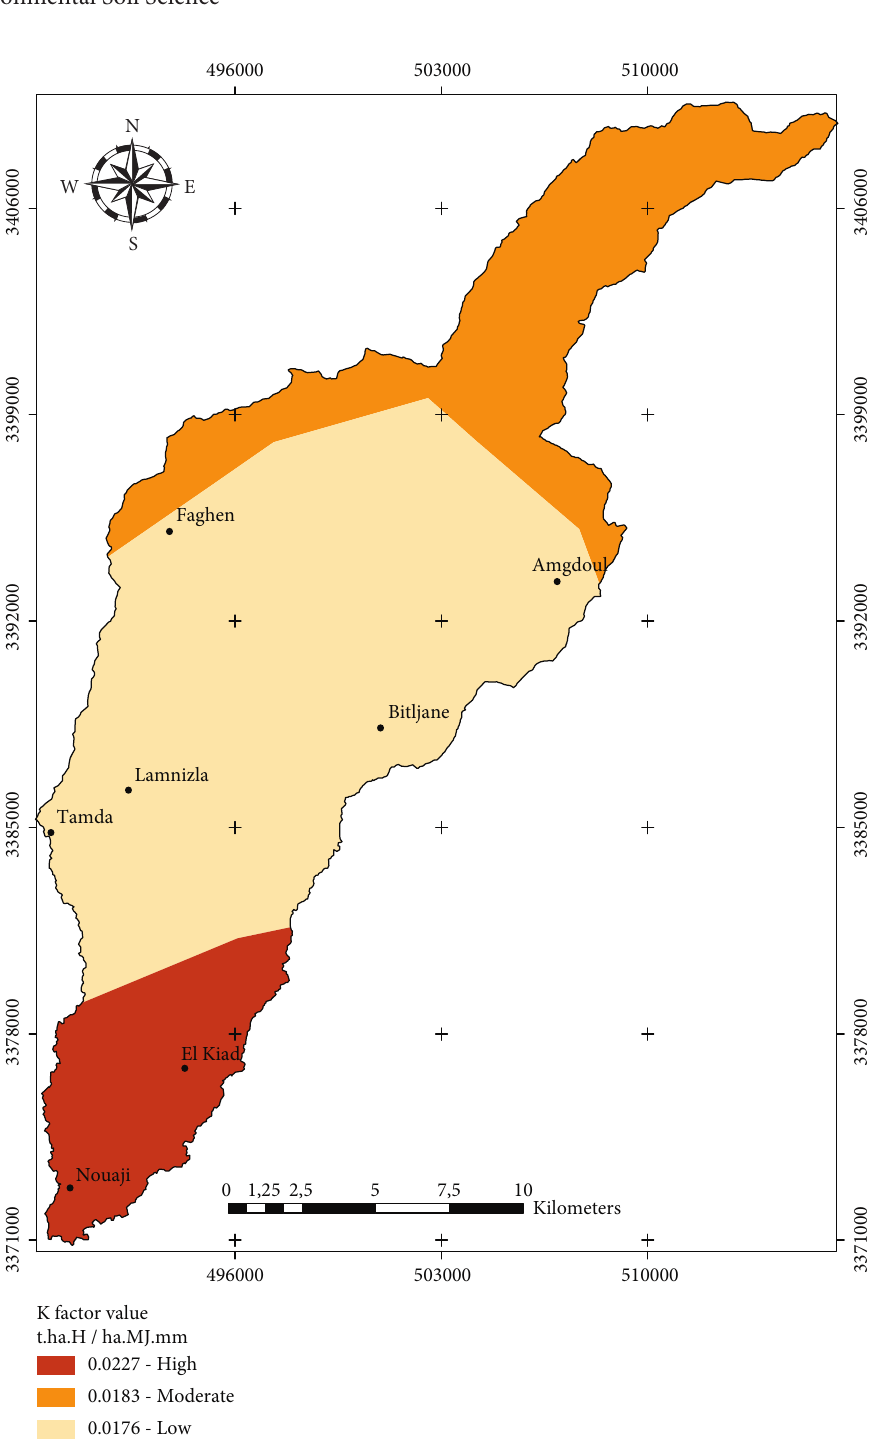
Figure 5: Spatial distribution of soil erodibility factor K at Beni Mohand River